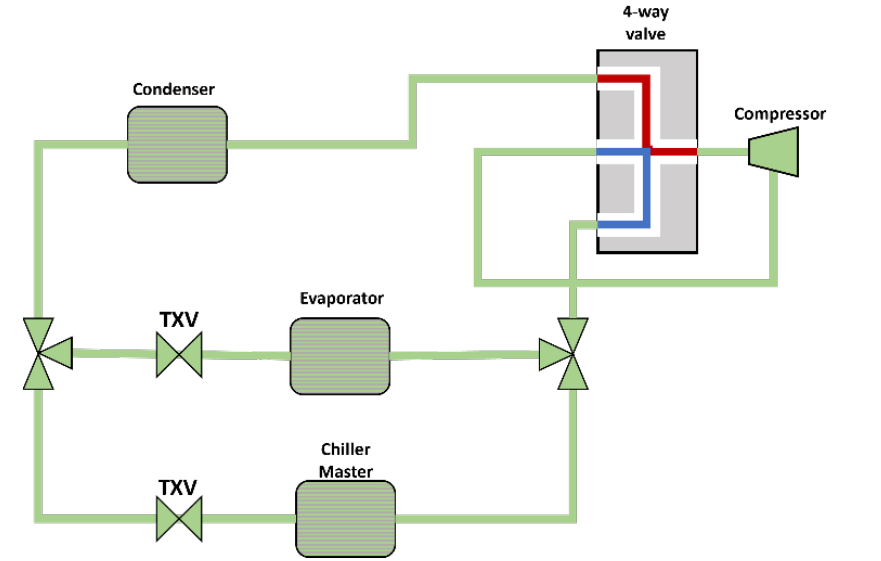
Figure 15. Scheme of the air conditioning system circuit.